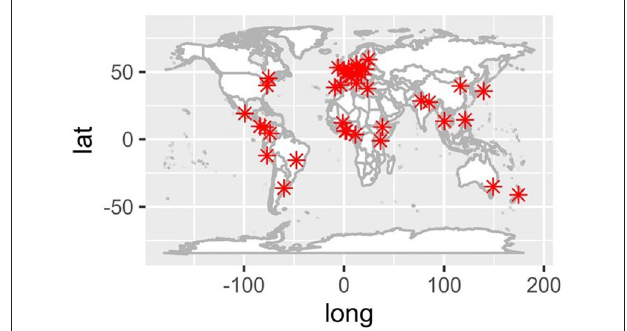
FIGURE 1 | World map showing the countries where the selected primary studies were run.